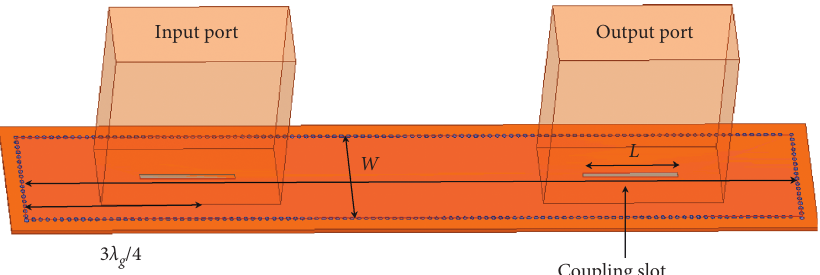
Figure 4: A scheme in which a rectangular waveguides (RWGs) are used to excite and observe field pattern of substrate-integrated waveguide